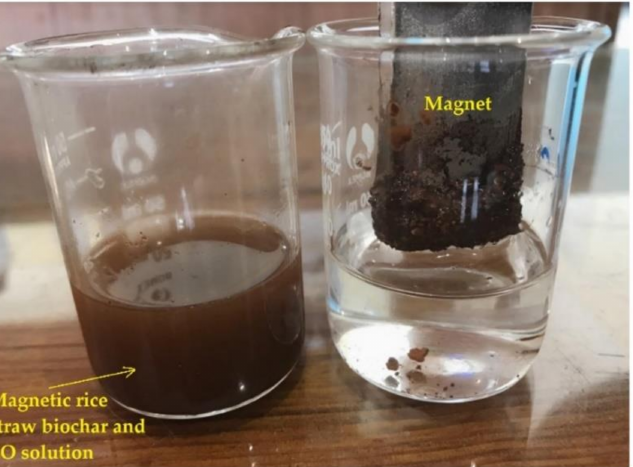
Figure 9. Introduction of an external magnet into the suspension of MRSB- and SO-contaminated water.